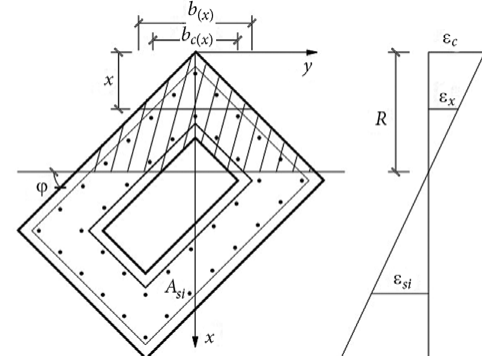
Fig. 4. M– φ Analytical